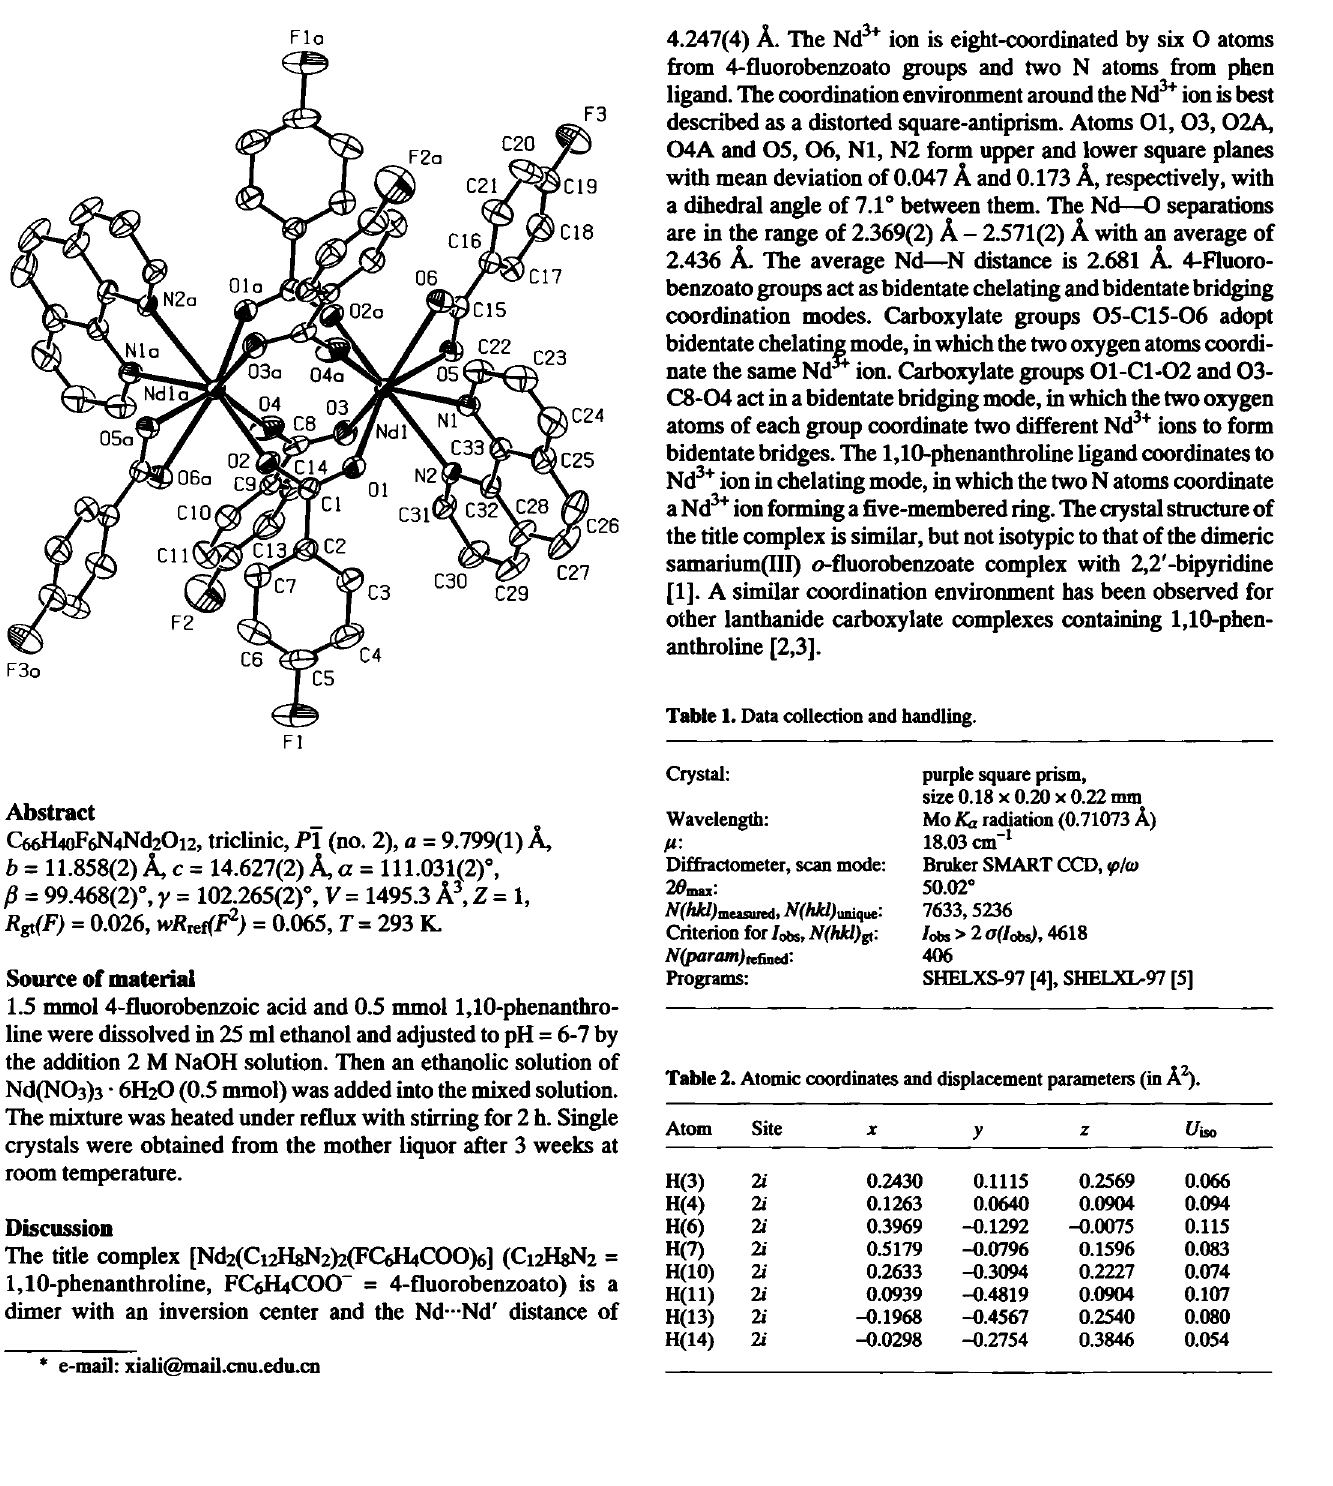
Table 2. Atomic coordinates and displacement parameteis (in Ä 2